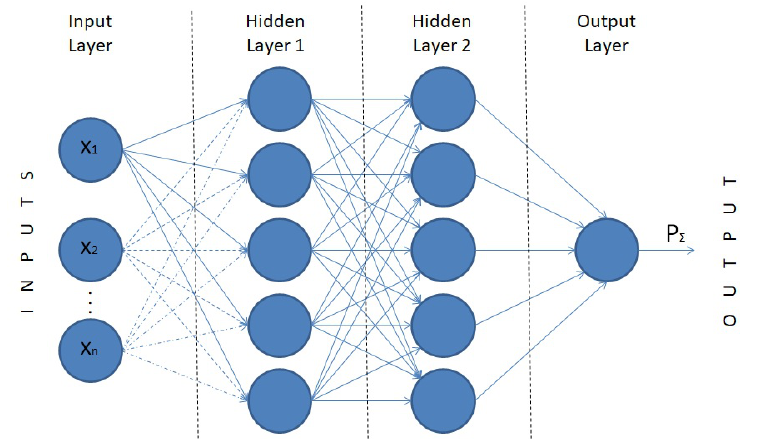
Figure 7. The neural network structure for the analysis of the impact of external factors on the wind power plant